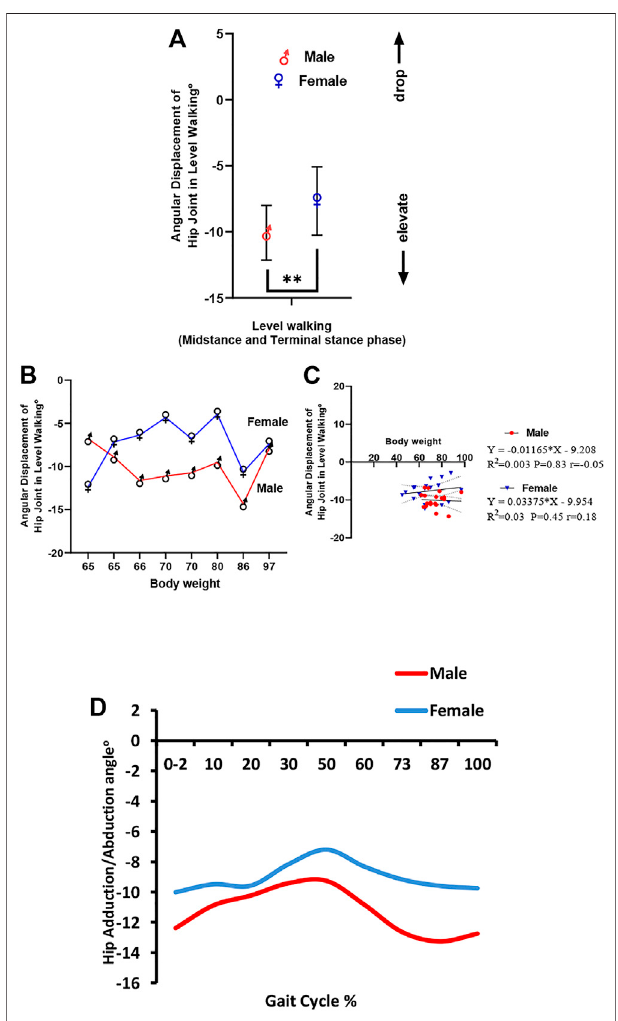
FIGURE 6 | (A) Angular translation of the hip joint in the coronal plane in male and female participants. (B) Inter-subject variation in angular displacement of the hip joint in the coronal plane in male and female participants by weight. (C) Linear regression of body weight versus angular displacement of the hip joint during level walking. (D) Hip adductor/ abductor angle in male and female participants during the gait cycle in level